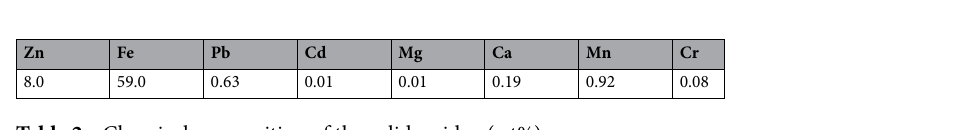
Table 2. Chemical composition of the solid residue